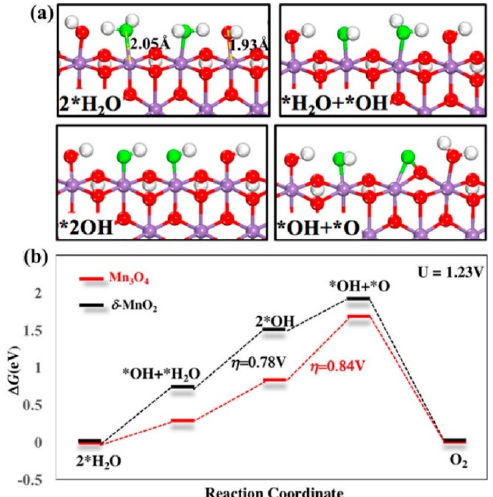
Figure 13. ( a ) The intermediates of the OER on the edge site of δ-MnO 2 . H 2 O and terminal OH become adsorbed on the Mn 5c . The structures of intermediates on spinel Mn 3 O 4 and δ-MnO 2 of OER are similar. ( b ) OER energetic profiles diagram on Mn 3 O 4 and δ-MnO 2 . Color code: O, red; H, white, Mn, violet. The oxygen that are involved in the reaction are represented by green color. (Reprinted from ref. [60] with permission from American Chemical Society. Copyright © 2018, American Chemical Society).